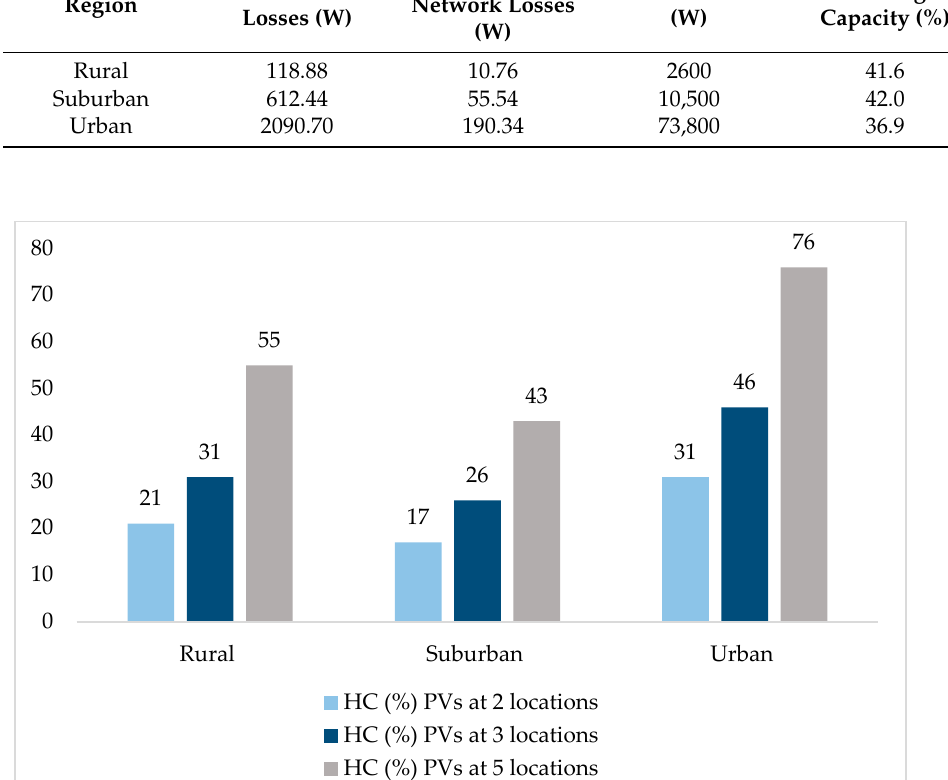
Figure 11. HC variation with PV distribution as concentrated and dispersed.